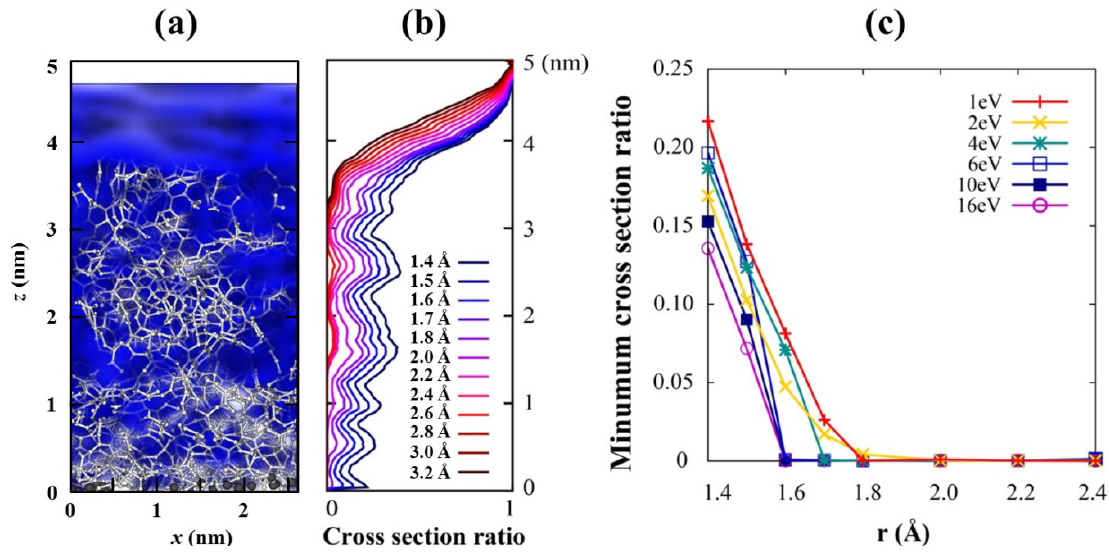
Figure 2. ( a ) Ionic channels with r =1.6 Å (blue cloud) through the film where Li ions will defuse along it. ( b ) The cross section ratio of the channels, which is the relative size of the Li channel compare to the total cross section, from the top surface of the carbon to the C/Si interface for 1 eV deposition energy with various r . 0 stands for complete closing of the channel, while 1 does complete opening of the channel. ( c ) Minimum value of the channel cross section ratios for films with various incident energies. The Li channel with r ≥ 1.6 Å closes for high incident energies above 4